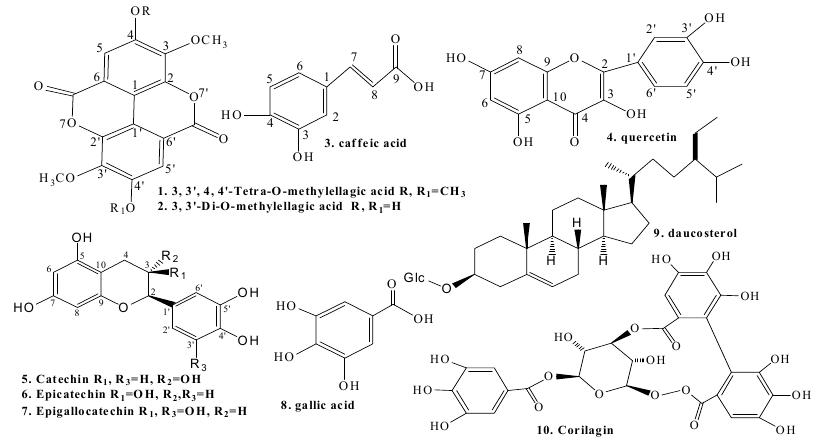
Figure 2. Chemical structures of the major compounds isolated from 50% ethanol extract of Geranium collinum .